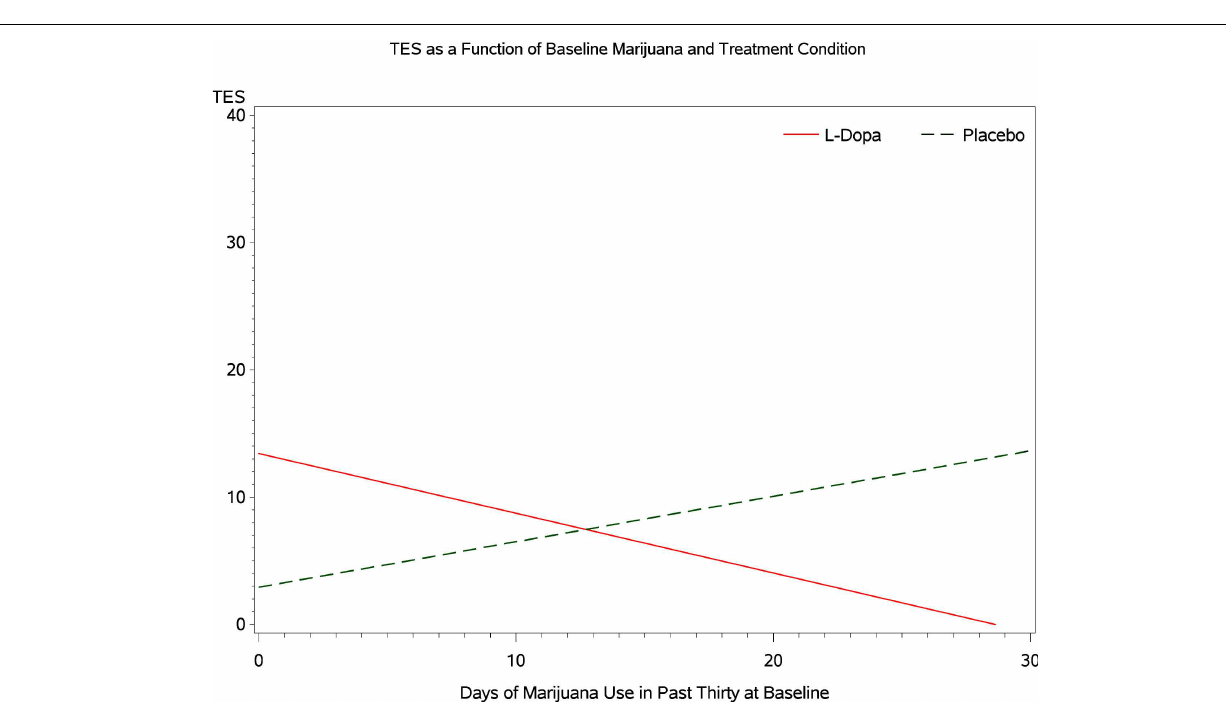
FIGURE 6 | Posterior densities for the simple effect of baseline marijuana use within each condition.